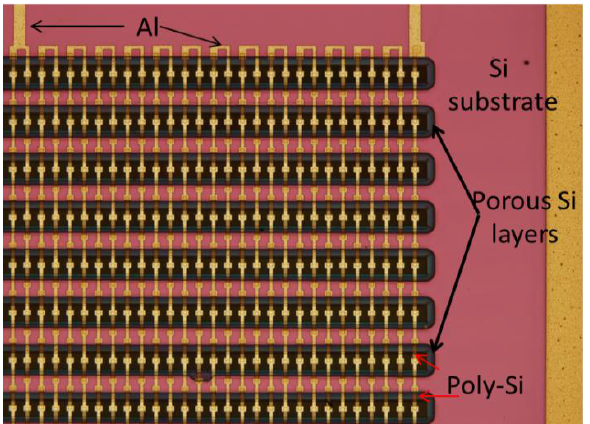
Figure 3. Optical microscope image of a part of the fabricated TEG without the top photoresist and Al